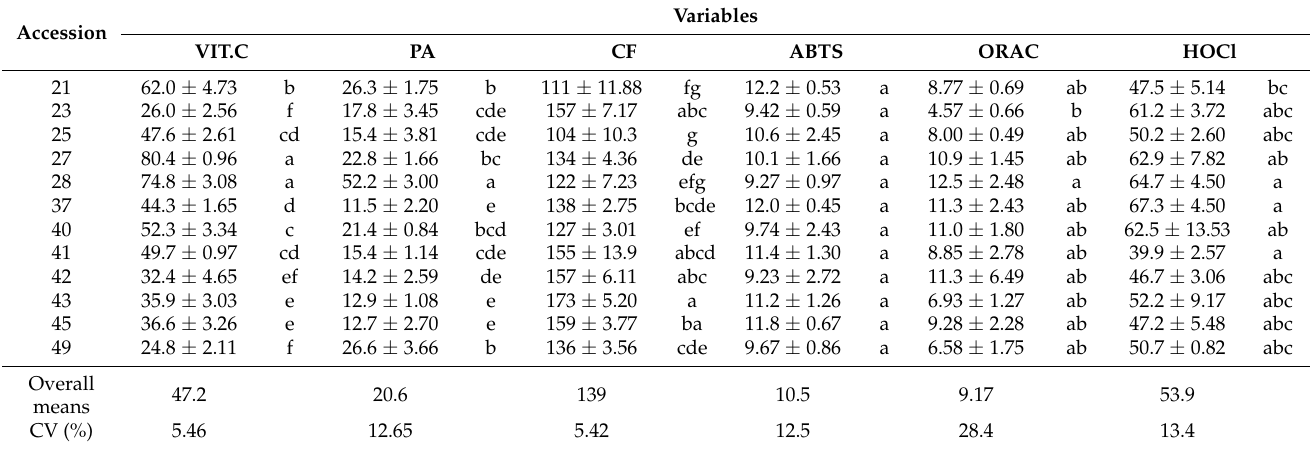
Table 1. Vitamin C, proanthocyanidin and phenolic compound contents and antioxidant activity of the 12 cambuci accessions investigated in the present